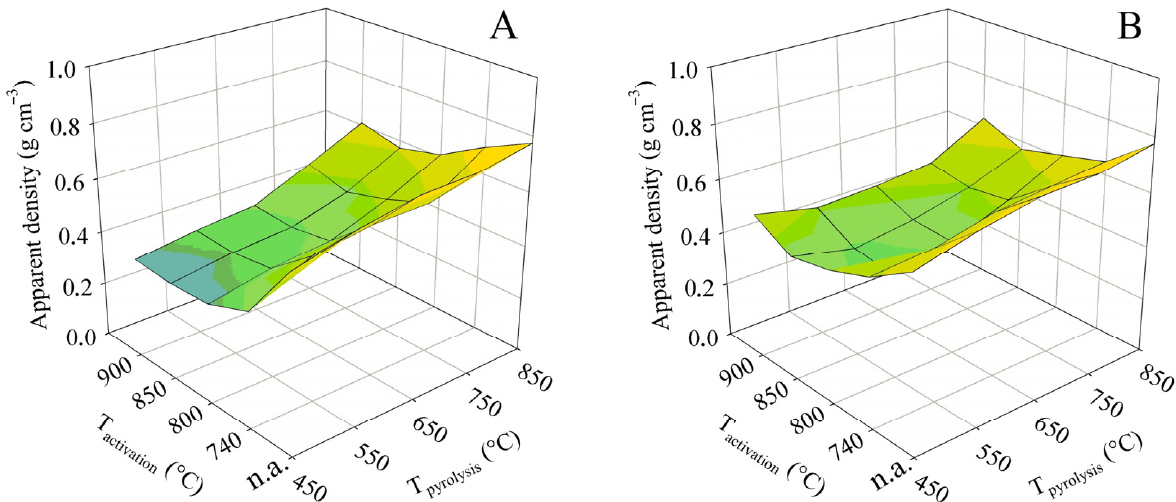
Figure 10. The impact of the pyrolysis and activation conditions on apparent density for series ( A , B ).